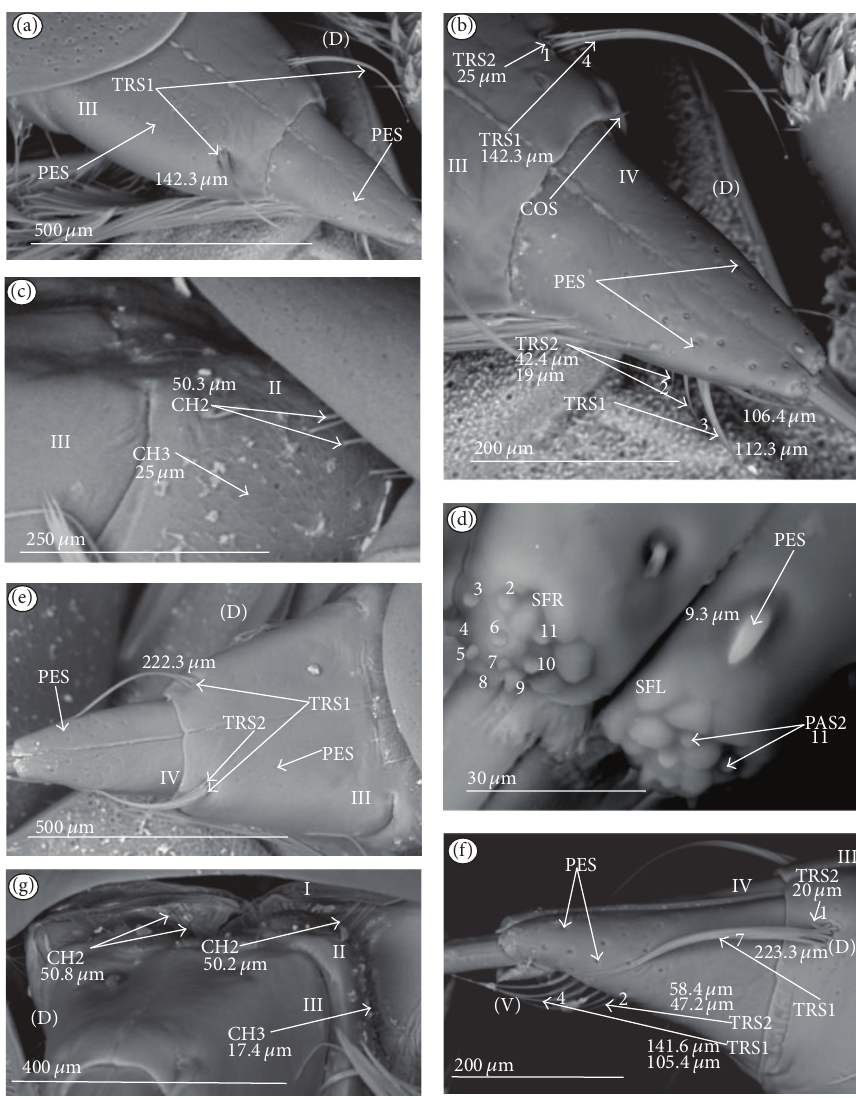
Figure 20: Types and sizes of the sensilla of the Naucoridae: Laccocorinae ((a)–(d), Laccocoris hoogstraali , (e)–(g), Heleocoris humeralis ). (a) PES are numerous and distributed evenly on the IV segment (dorsal view). (b) TRS1 (three) and TRS2 (two) are distributed on the ventral (V) and dorsal (D) sides, and TRS1 (four) and TRS (two) are situated d in one tuft on the distal edge of the III segment. (c) CH3 densely cover the dorsal surface on the II segment; several CH2 are present. (d) PAS2 (no. 1–11) are distributed over SFL and SFR. (e) TRS1 and TRS2 are placed in one tuft on the distal edge of the III segment; PES are distributed evenly on the dorsal surface of the IV segment but are less numerous on the III segment. (f) PES are numerous and distributed evenly on the IV segment (lateral view); TRS2 (two) and TRS1 (four) are distributed ventrally (V) and dorsally (D); TRS1 (seven) and TRS2 (one) are distributed on the distal edge of the III segment. (g) CH3 densely cover the dorsal surface (D) of the II segment; only several CH2 are